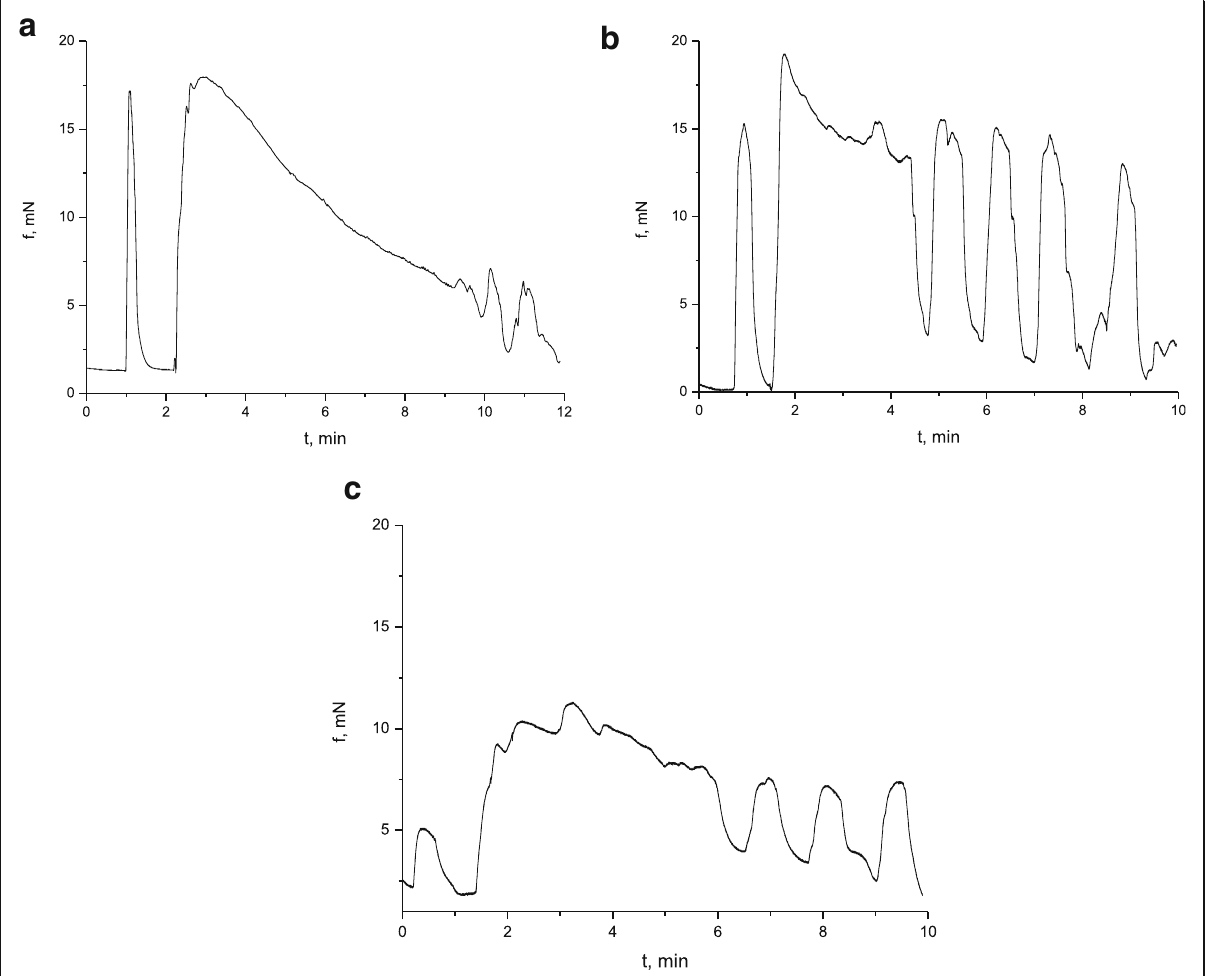
Fig. 7 Oxytocin-induced (0.1 IU) contraction of smooth muscles of the myometrium of the rats in the control group ( a ) and the group of rats, burdened with the suspension of titanium dioxide for 30 days ( b ) and 100 days ( c